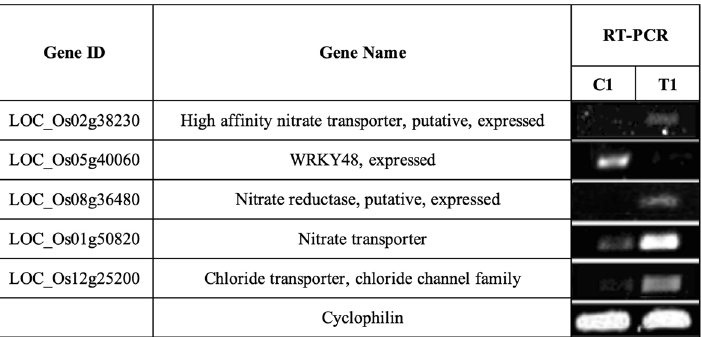
Figure 4. Validation of the expression pattern of five differentially expressed genes by RT-PCR. In these experiments, C1 and T1 represent cDNA synthesized from control and bacteria-inoculated samples. RT-PCR was performed in three biological replicates for all the samples, and Cyclophilin was used as an internal